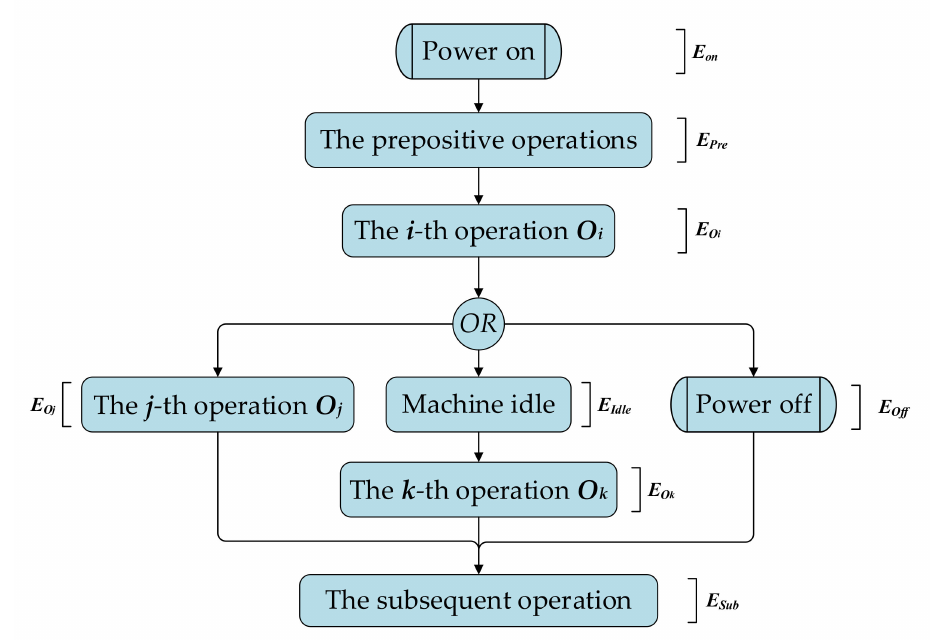
Figure 1. An example of a machine’s running state and energy consumption